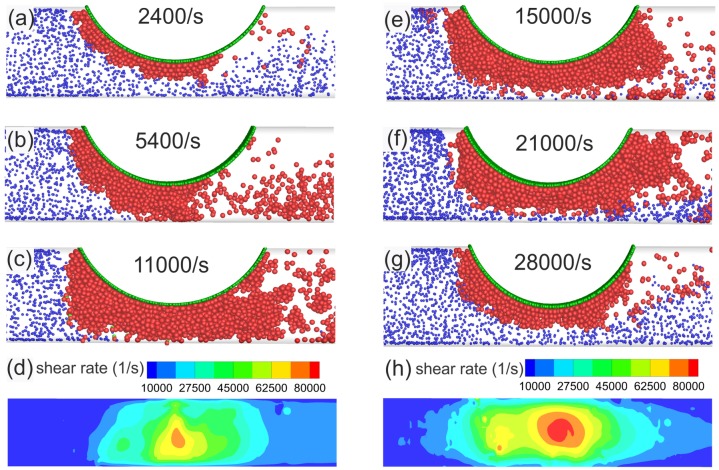
Simulation results for platelet aggregation at high shear rates in a fixed geometry with 60% stenosis, whereas the increase in flow rate develops high shear rates in the stenosis.Printed number in each figure is the undisturbed maximum wall shear rates encountered in each stenosis (before aggregation occurs). Full occlusion is observed in (b) and (c). Color coding for particles is the same as in Fig 3, and green particles are seeded on the circular arc only. Here, the activation delay time is τact = 0 s. (d) and (h) Wall shear rate contours plotted on the opposite wall of the arc for the simulations with undisturbed wall shear rate values of 15,000 and 28,000 s−1, respectively.